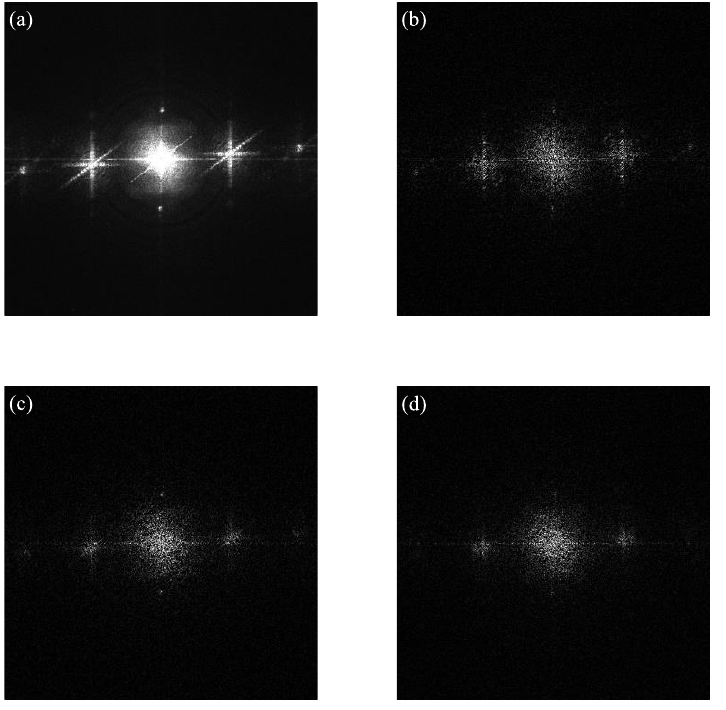
Figure 3. ( a ) Approximation factor; ( b ) horizontal detail component; ( c ) vertical detail component; and ( d ) diagonal detail